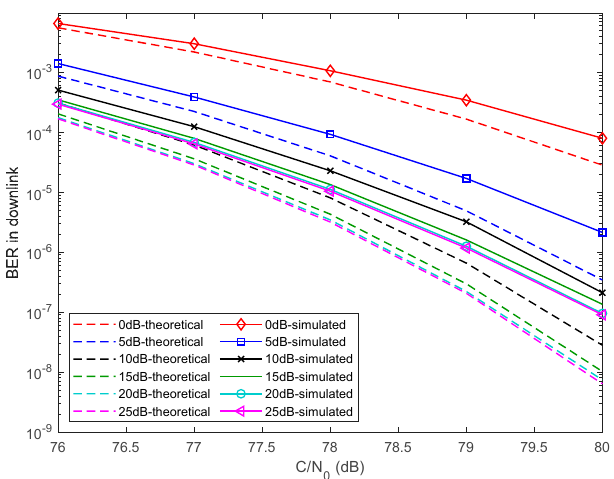
Figure 10. BER of downlink under different PWDF.